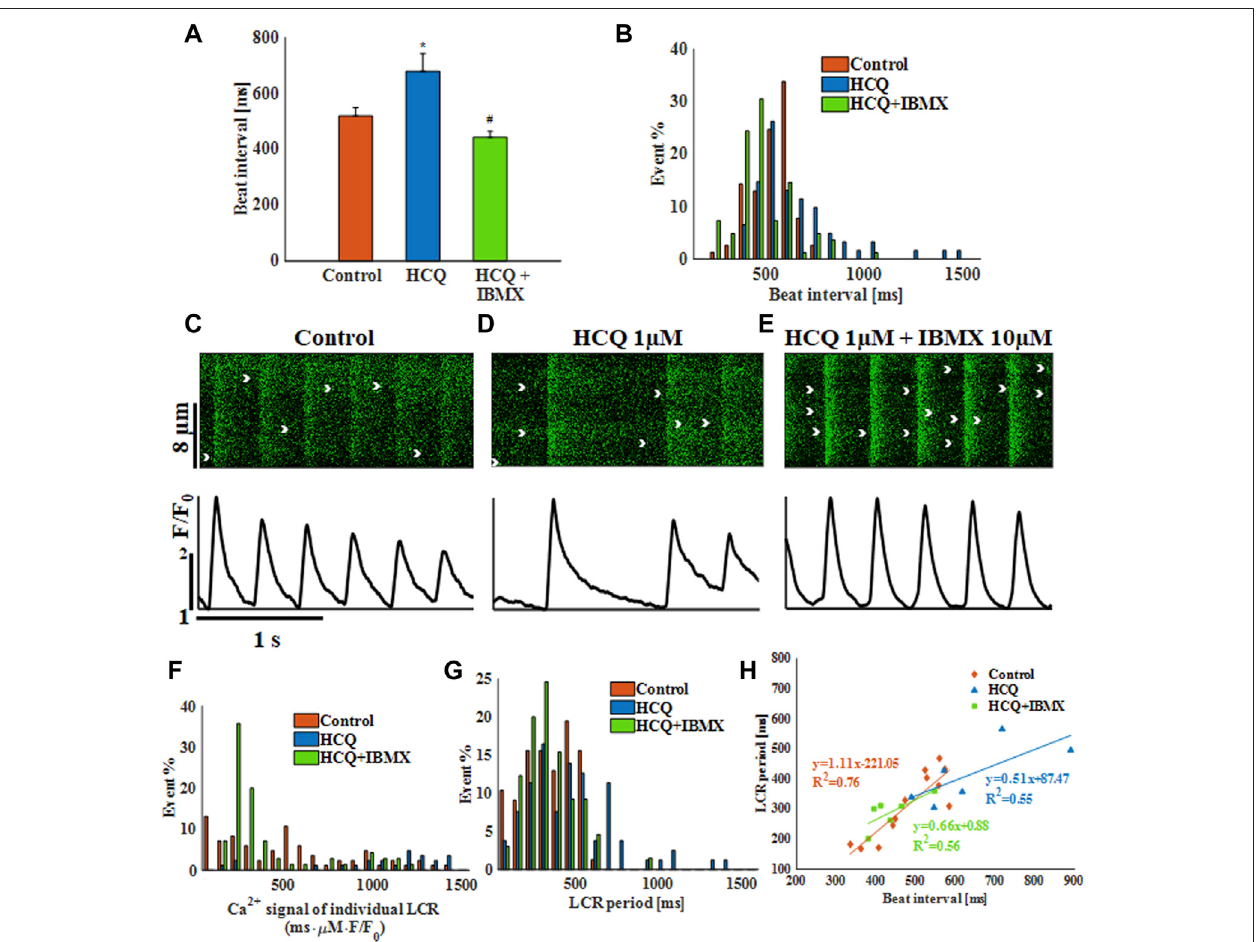
FIGURE 5 | The effect of hydroxychloroquine (HCQ) with 3 ′ -isobutylmethylxanthine (IBMX) on single rabbit sinoatrial node cells. (A) Mean beat interval and (B) beating interval distribution of control and of 1 μ M HCQ- ( n = 7) or 1 μ M HCQ + 10 μ M IBMX-treated single rabbit sinoatrial node (SAN) cells ( n = 7). Representative exampleofCa 2+ transientsin (C) controland (D) 1 μ MHCQ-or (E) 1 μ MHCQ+10 μ MIBMX-treatedSANcells.Thedistributionof (F) Ca 2+ signalofindividualLCRs,and (G) LCRperiodincontrolandin1 μ MHCQ-or1 μ MHCQand10 μ MIBMX-treatedSANcells. (H)